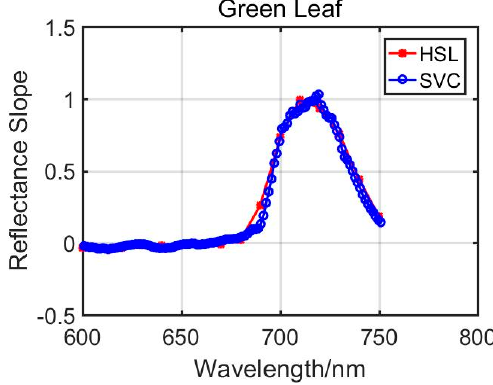
Figure 10. Radermachera green leaf. Table 2. “Red edge” position measuring results based on FRS.